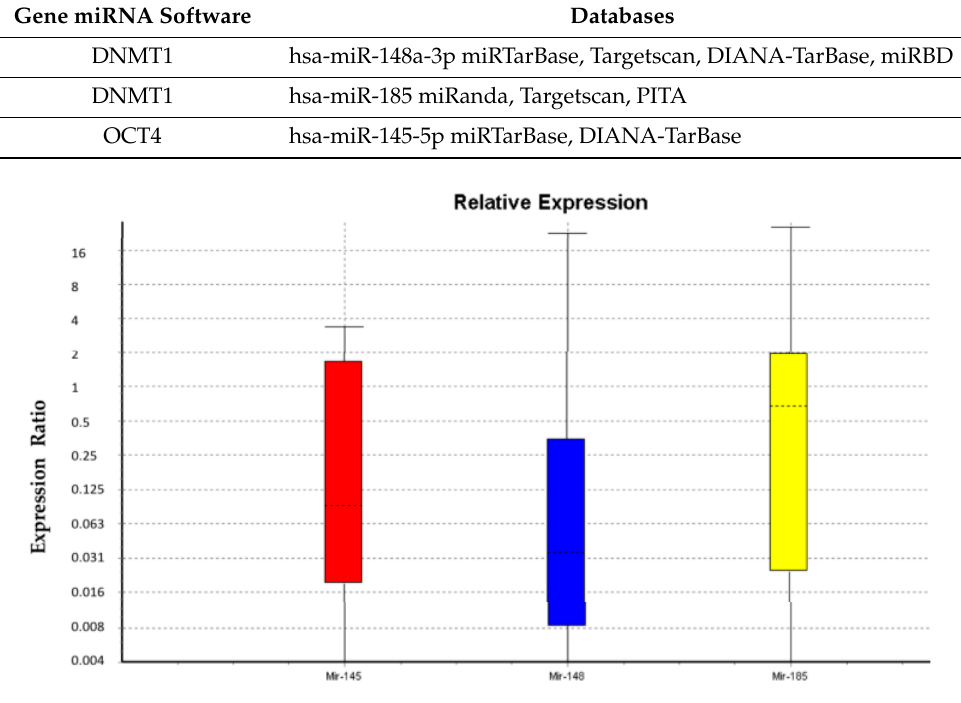
Figure 1. Expression of miRNAs. The graph shows a trend in miRNA expression: miR-145-5p, miR-148a-3p, and miR-185-3p of Wharton jelly multipotent stem cells (WJ-MSCs) from females as compared to WJ-MSCs from males. Table 2. Relative expression of miRNAs (WJ-MSCS by females compared to WJ-MSCs of males): Table 1. Target genes and miRNAs selected using the indicated bioinformatic tools. standard error, 95% confidence interval (CI), and p -value of